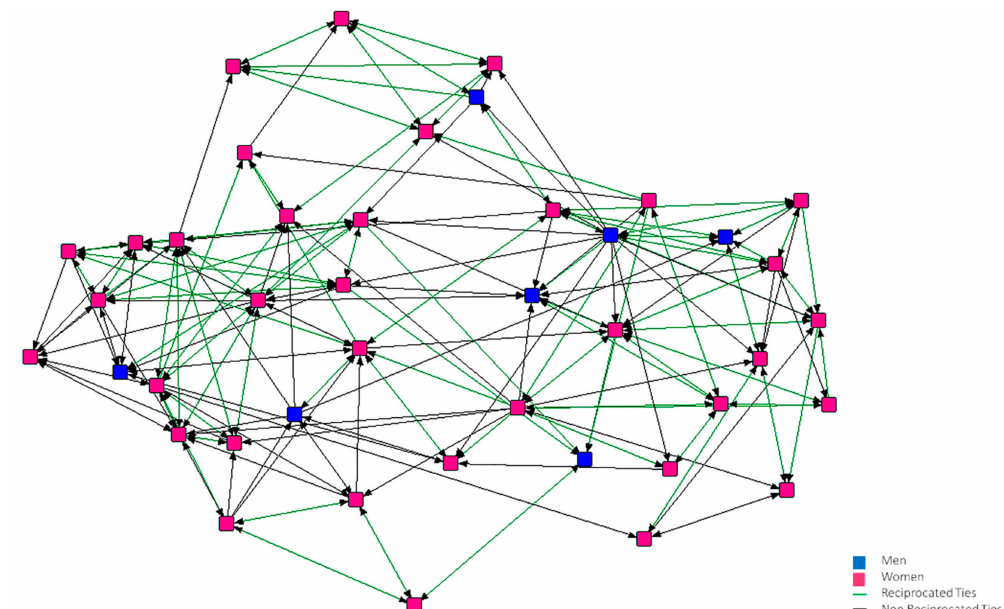
Figure 4. Graph of the third year Friendship